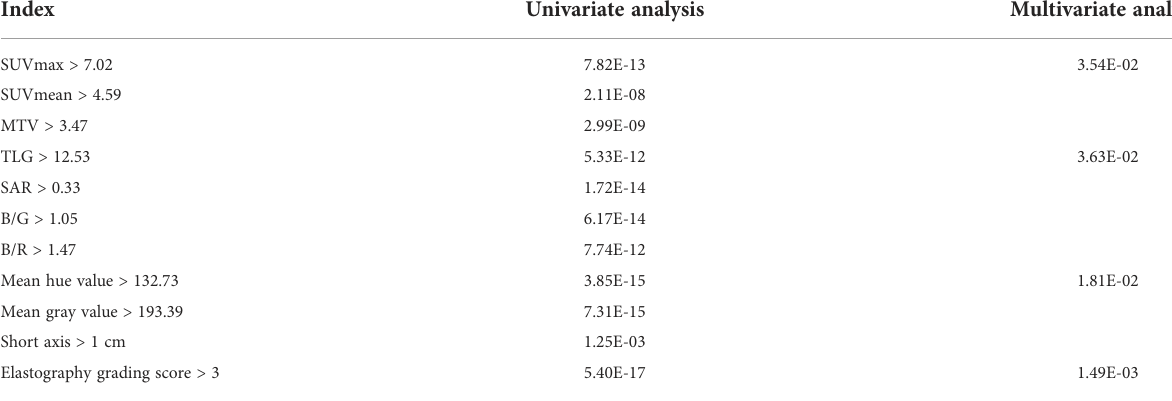
TABLE 3 Univariate and multivariate analyses of PET/CT and elastography parameters in the model group. Index